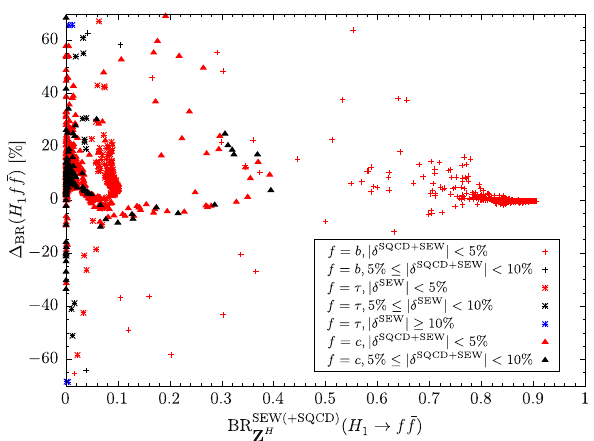
Fig. 2 Scan1: Relative difference (cid:20) BR (see text, for definition) in per- cent for the H 1 decays into b ¯ b ,τ ¯ τ, c ¯ c . Red: relative corrections δ (see text, for definition) in percent of the SUSY-EW(+SUSY-QCD) correc- tions to the decay widths with | δ | < 5%; black: 5 ≤ | δ | < 10%; blue: | δ | ≥ 10% (cid:20) (cid:20) (cid:20) δ SEW+SQCD (cid:20) is in the [20,40]% range; in Fig. where